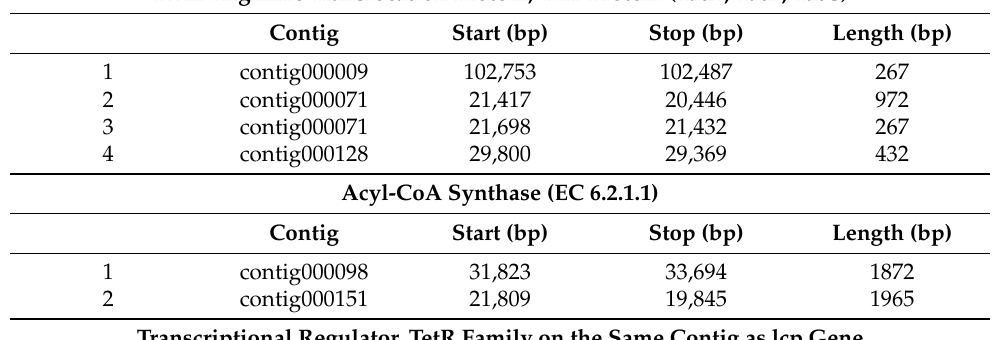
Table A12. Distribution and loci of β -oxidation related putative genes in the draft genome of Dactylosporangium sp.